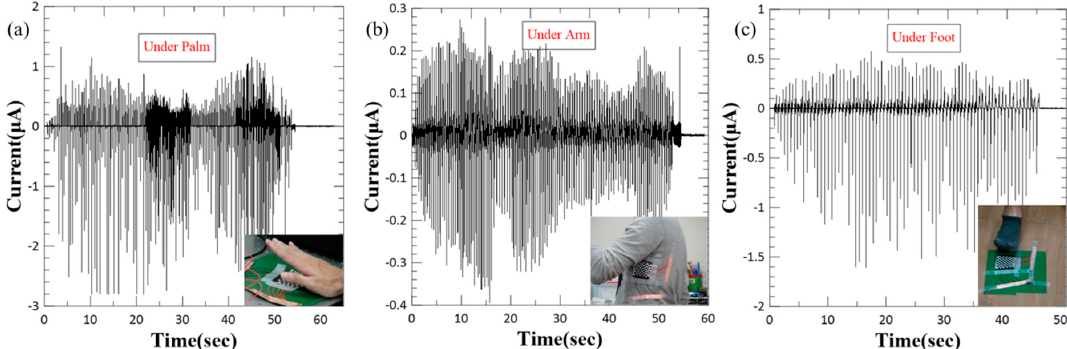
Figure 8. Applications of WTENG to harvest mechanical energy from human motion: ( a ) Tapping by hand. ( b ) Integrated into clothing to harvest energy from arm movement. ( c ) Stepping during walking.